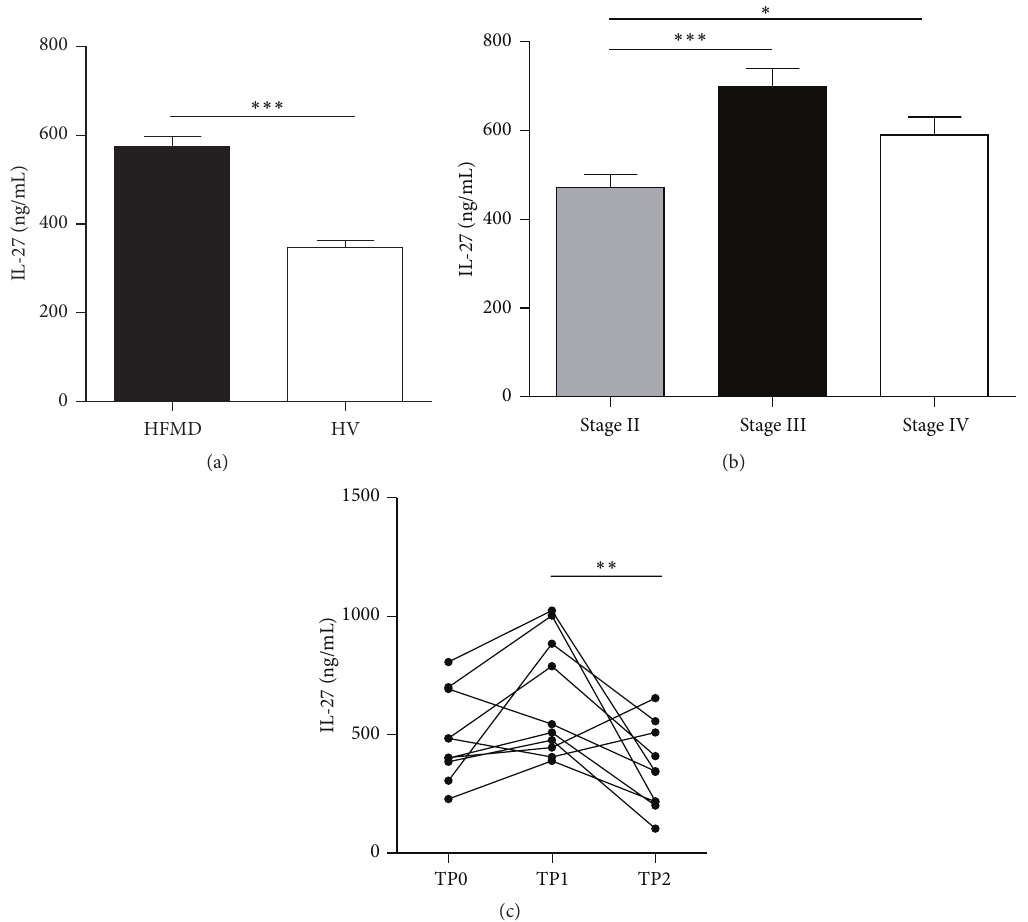
Figure 1: Serum IL-27 levels in EV71-infected patients. Serum IL-27 levels in 127 EV71-infected HFMD patients (including 55 clinical stage II cases, 42 stage III cases, and 30 stage IV cases) and 95 healthy controls were detected by ELISA. Values are expressed as means ± SEM. (a) Serum IL-27 levels were significantly higher in EV71-infected HFMD patients than in healthy controls ( 𝑃 < 0.01 ). (b) Serum IL-27 levels in clinical stage III EV71-infected HFMD patients were higher than clinical stage II and clinical stage IV EV71-infected patients ( 𝑃 < 0.05 ). (c) Serum IL-27 levels in followed-up stage IV patients, the day of admission (TP0), the day the disease improved (TP1), and the day the disease